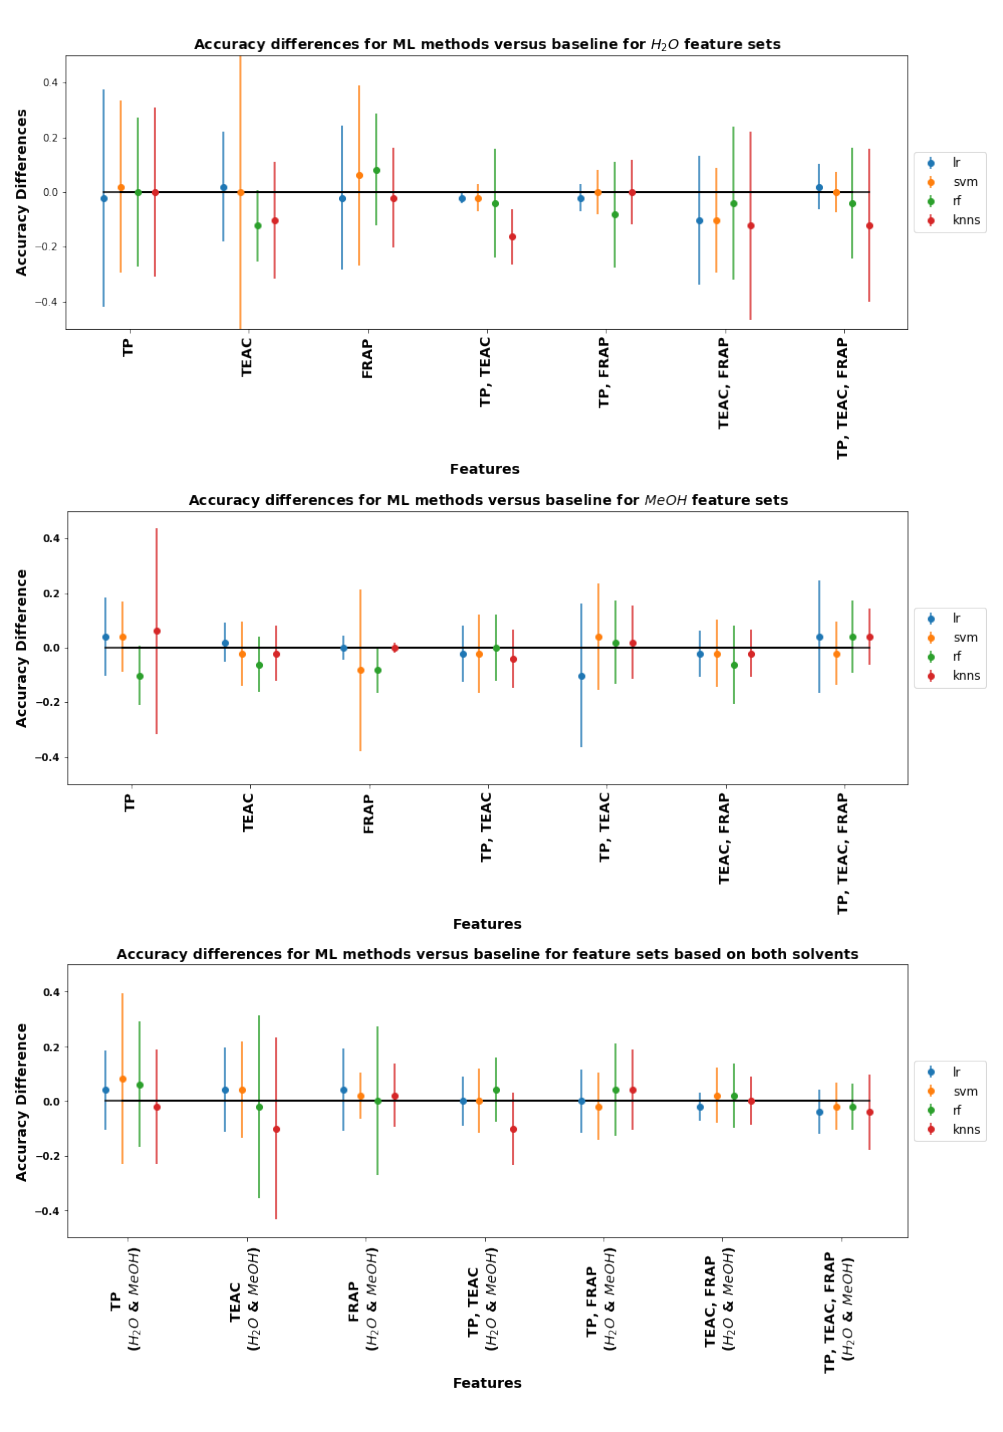
Figure 12. Final results of accuracy differences across all ML methods for classifiers based on water only ( top figure ), methanol only ( middle figure ) and both water and methanol ( bottom figure